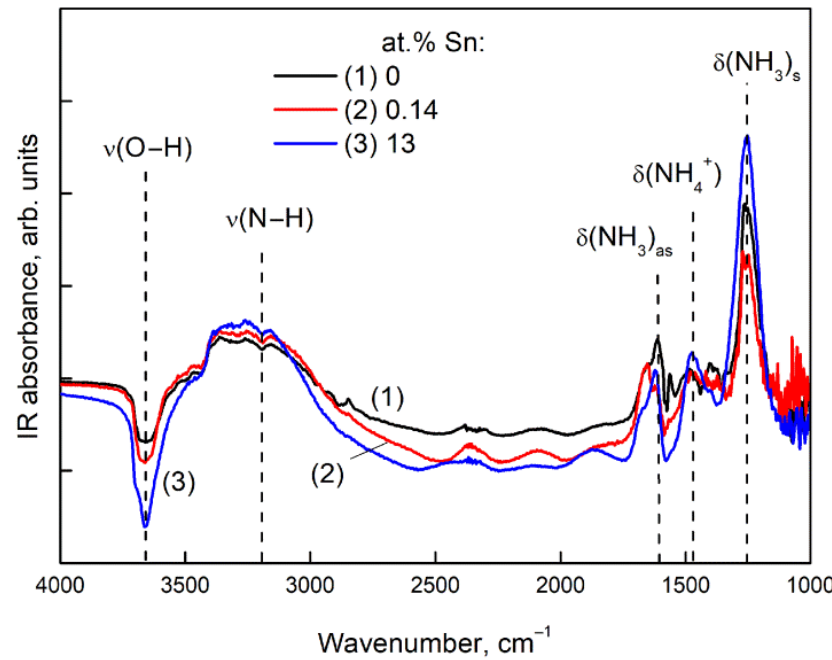
Figure 10. DRIFT spectra of Ga 2 O 3 (Sn) samples after exposure for 1 h in NH 3 (200 ppm) in air at room temperature: ( 1 ) 0, ( 2 ) 0.14, ( 3 ) 13 at.% Sn.